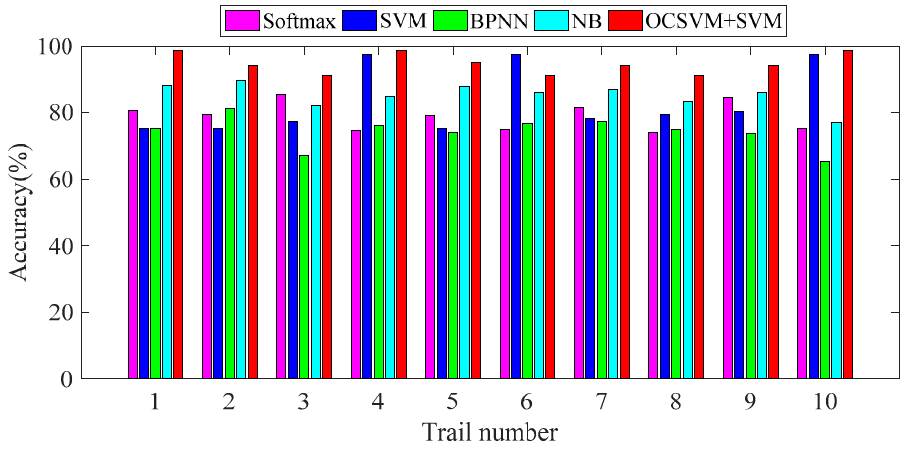
Figure 13. Diagnosis results of 10 tests with different methods.